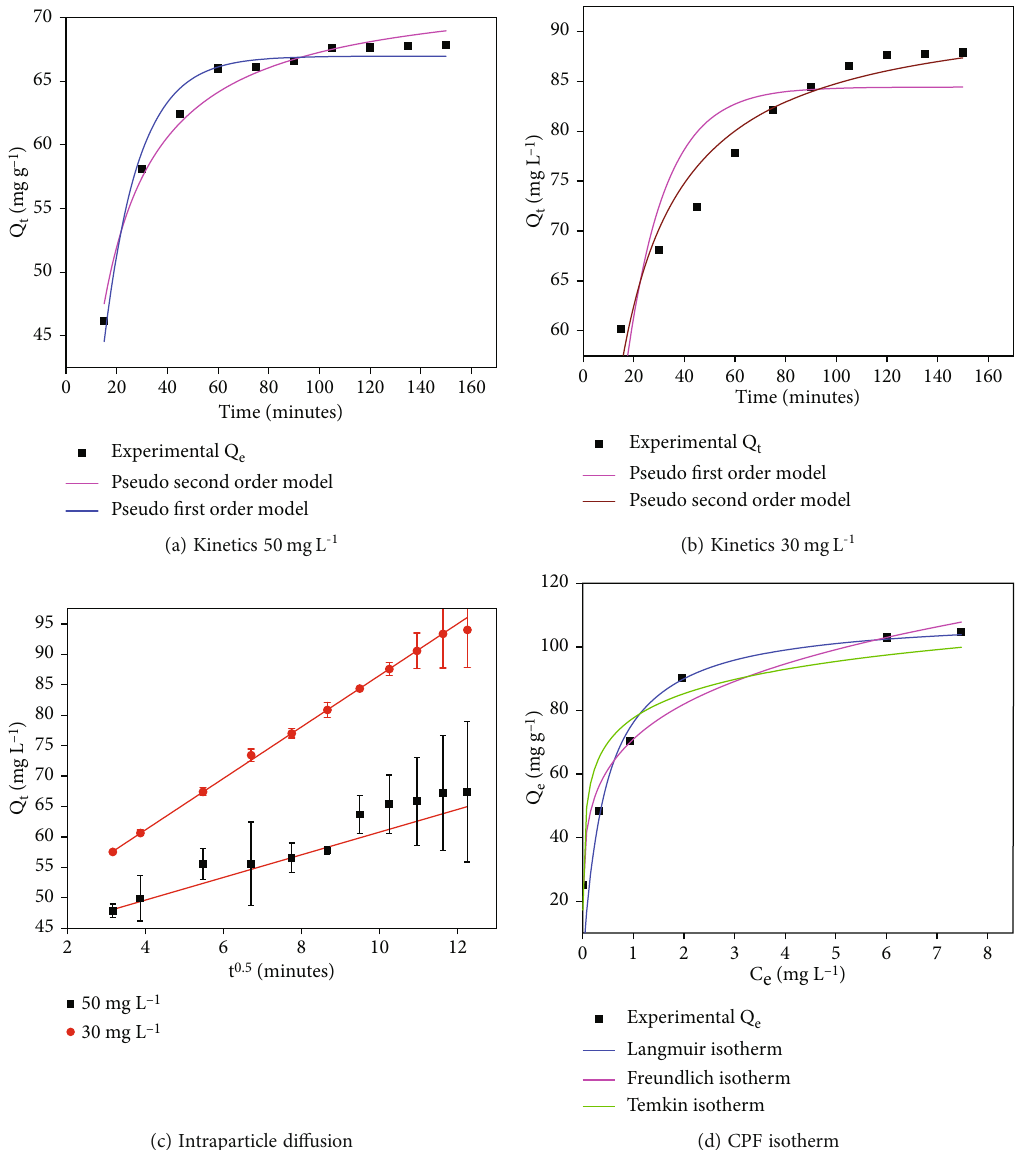
Figure 6: (a, b) Kinetics followed by CPF adsorbed by ACS, (c) pore di ff usion e ff ect of CPF in ACS, and (d) CPF isotherm.